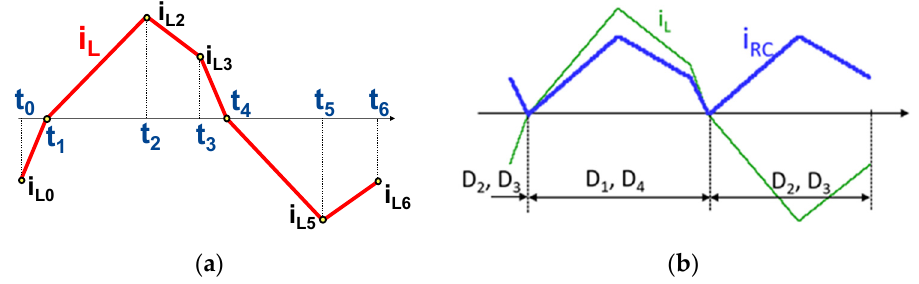
Figure 3. ( a ) Inductor current in CCM. ( b ) Inductor current and current injected into the output RC network through the corresponding output bridge diodes in CCM.